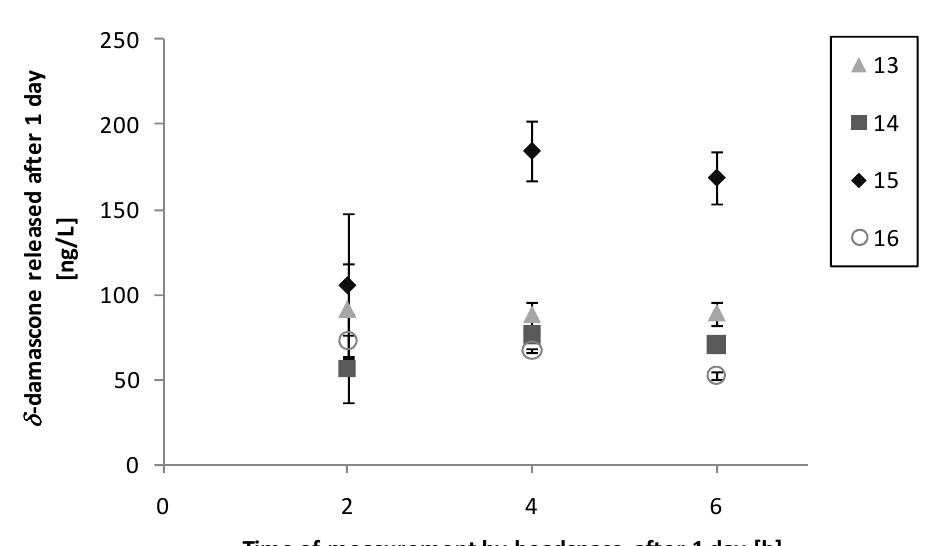
Figure 6. Headspace analysis of copolymers 13 – 16 as a function of time, measured after 24 h of line